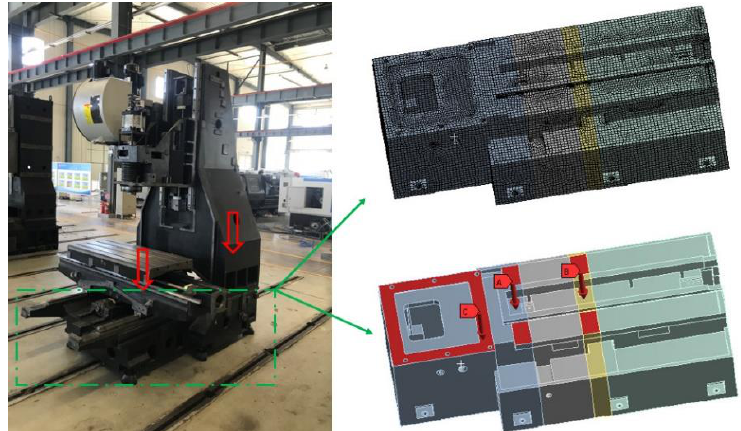
Figure 7. Milling machine tool and the sketch of the bed.